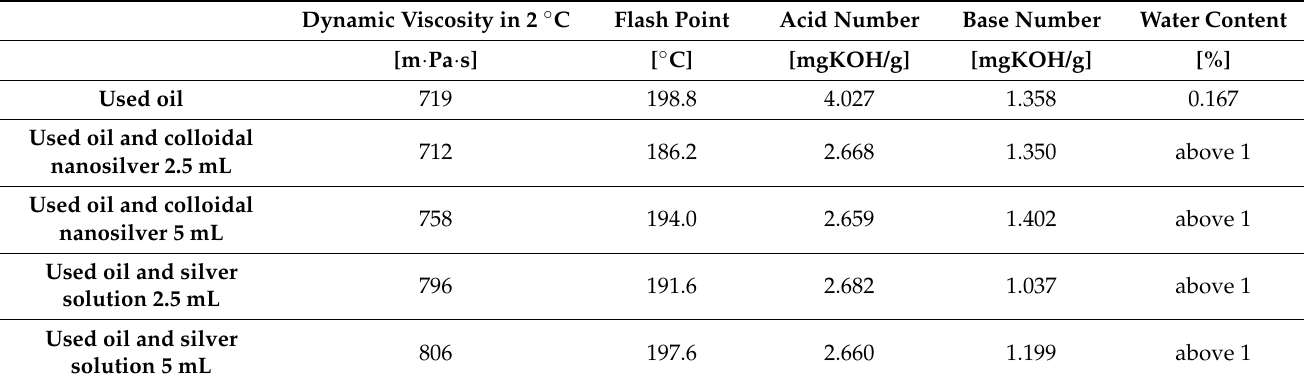
Table 5. Comparison of the parameters of waste oil without additives and waste oil with the colloidal nanosilver and silver